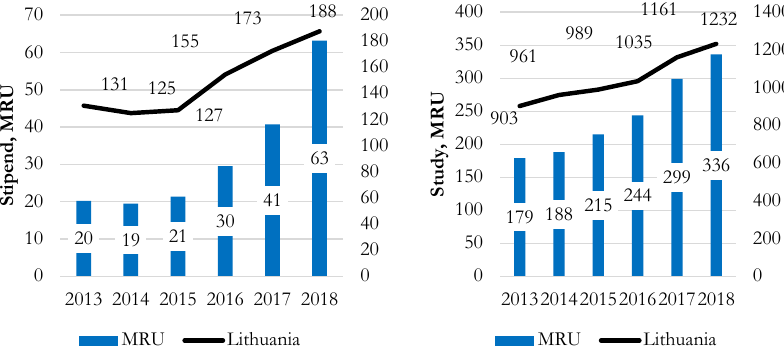
Fig. 6 – Lithuanian state budget appropriations per individual student in EUR. Source: own